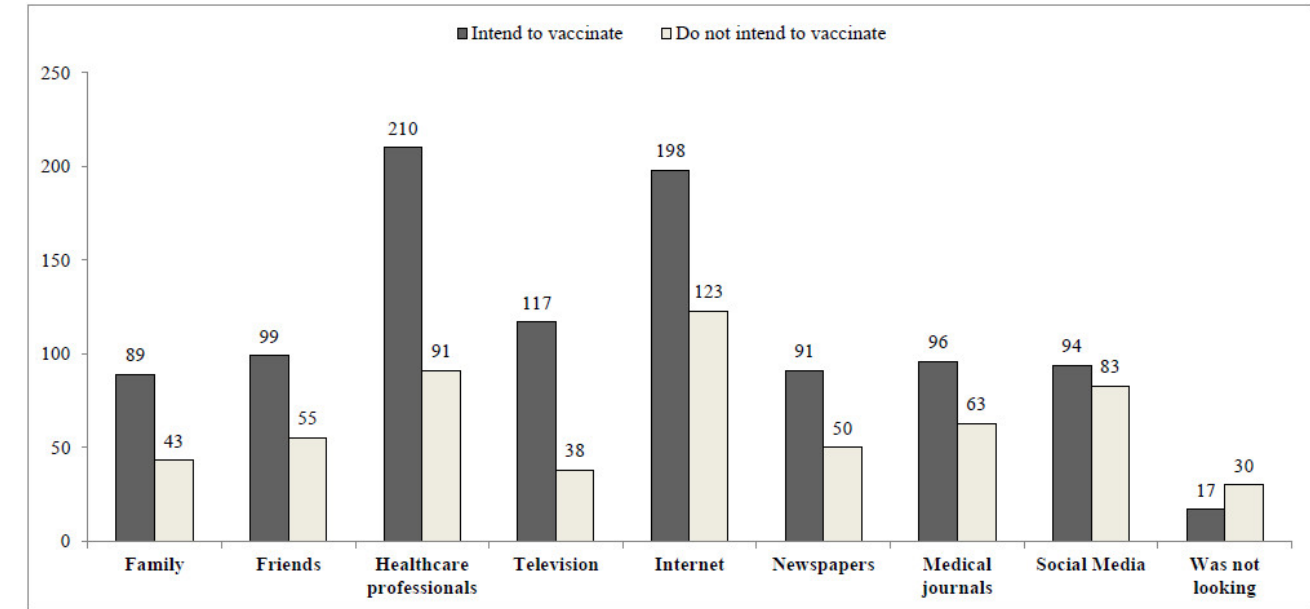
Figure 1. COVID-19 vaccine information sources, according to vaccination acceptance. Crude numbers, not mutually exclusive. Table 3. Mean VL functional, interactive and total scores, COVID-19 vaccine perception, the 5C components of vaccine behavior, and perceived vaccine hesitancy, according to COVID-19 vaccination acceptance.